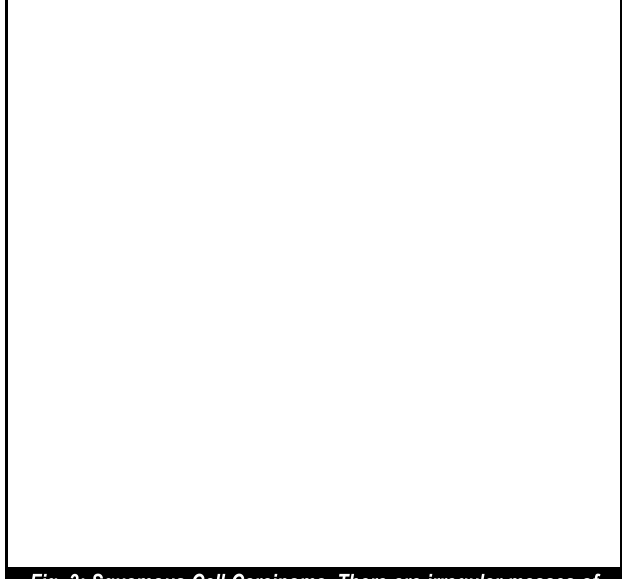
Fig. 3: Squamous Cell Carcinoma. There are irregular masses of epidermal cells proliferating downward into the dermis (H & E, X 4)